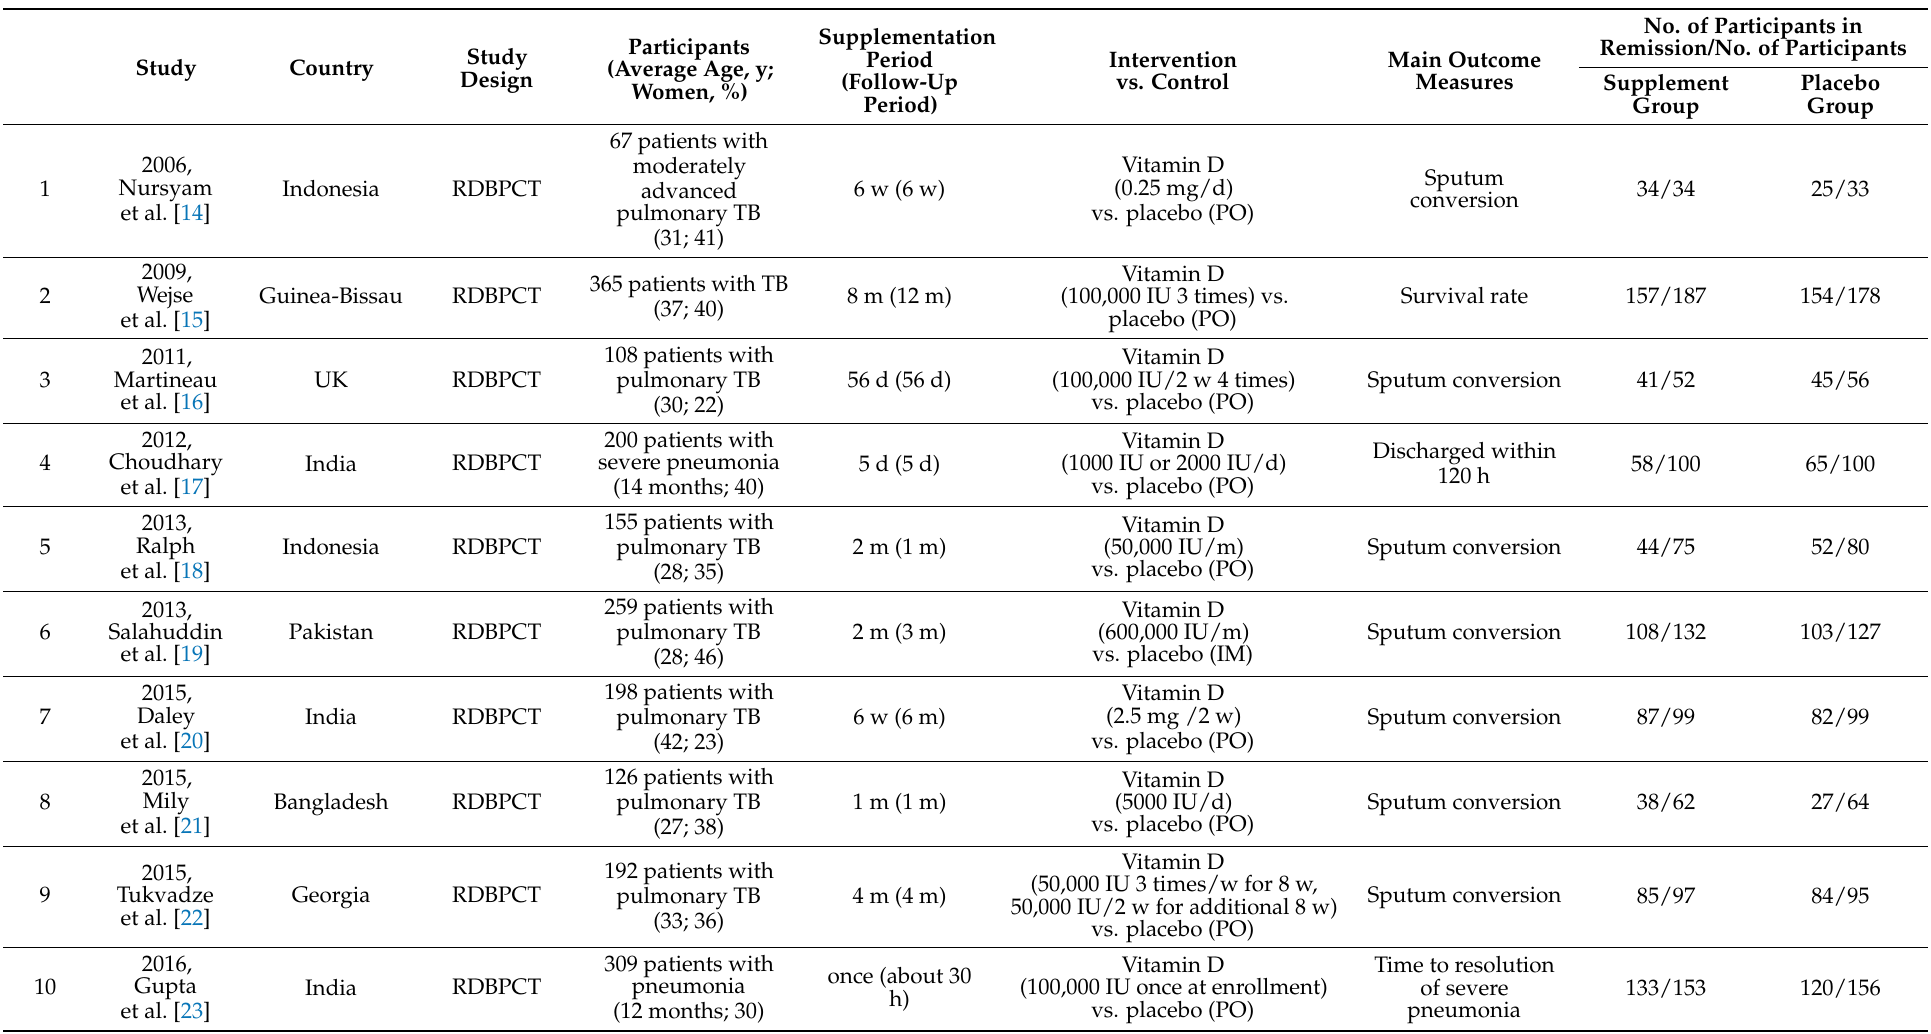
Table 1. Characteristics of studies included in the final analysis ( n =